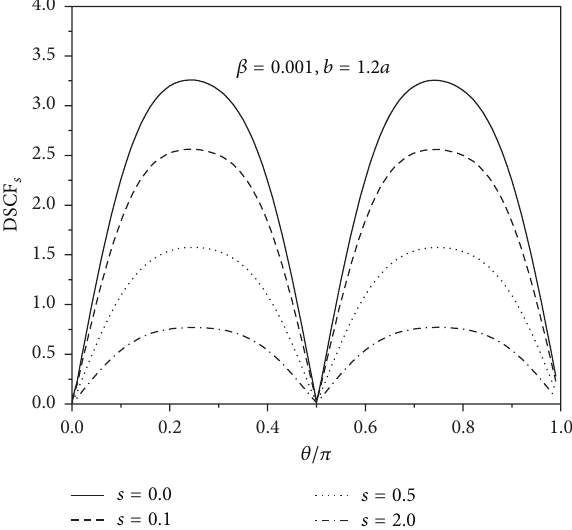
Figure 6: Surface effect on the distribution of DSCF along the middle hole for 𝛼 = 𝜋/2 and 𝑏 = 1.2𝑎 .